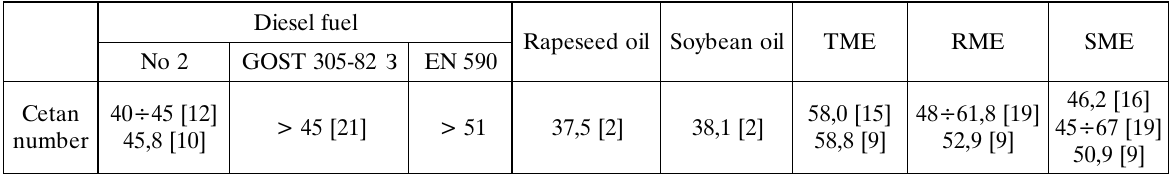
Table 7. Parameters of low temperatures of fuel